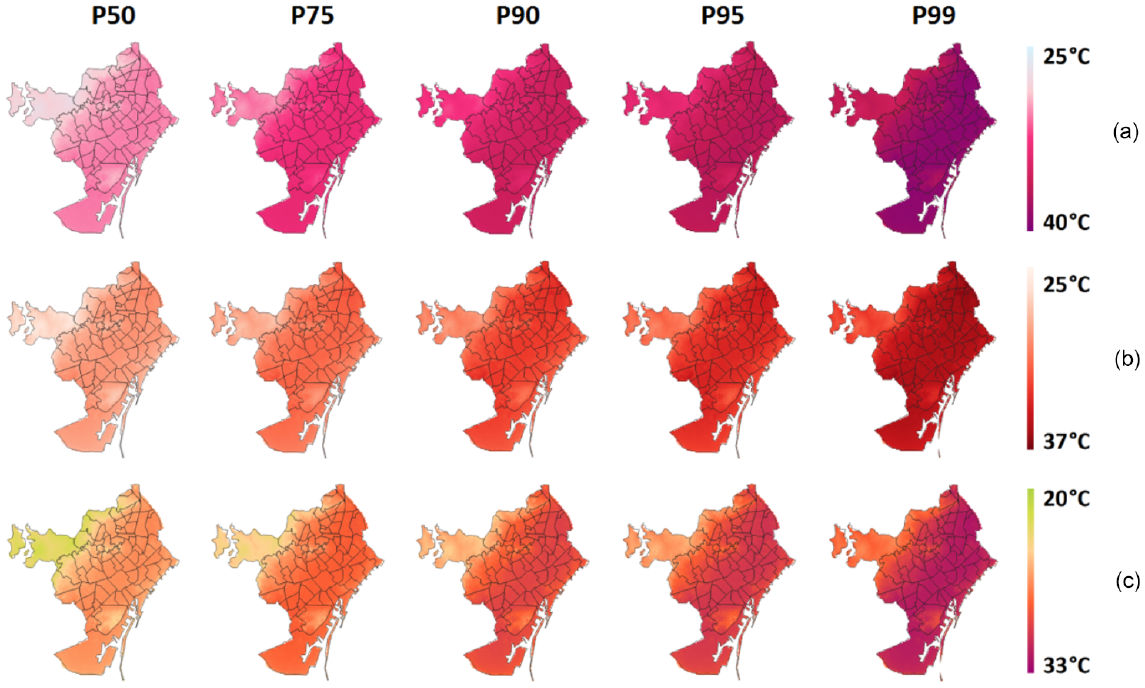
Figure 7. Climatological conditions in summer modelled by UrbClim (1987–2016): (a) humidex, (b) daily maximum temperature and